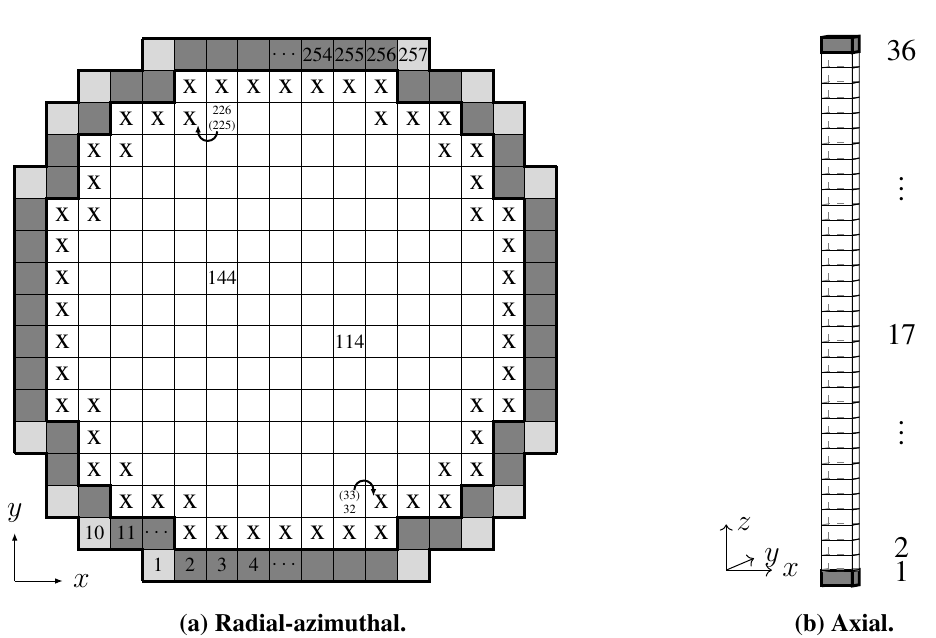
Figure 1: Spatial setup of the reactor in DYN3D . The fuel-assembly regions (white areas) and the the reflector regions (gray areas) are given by respective homogenized material parameters. Crosses indicate laterally fixed fuel assemblies for the mechanical